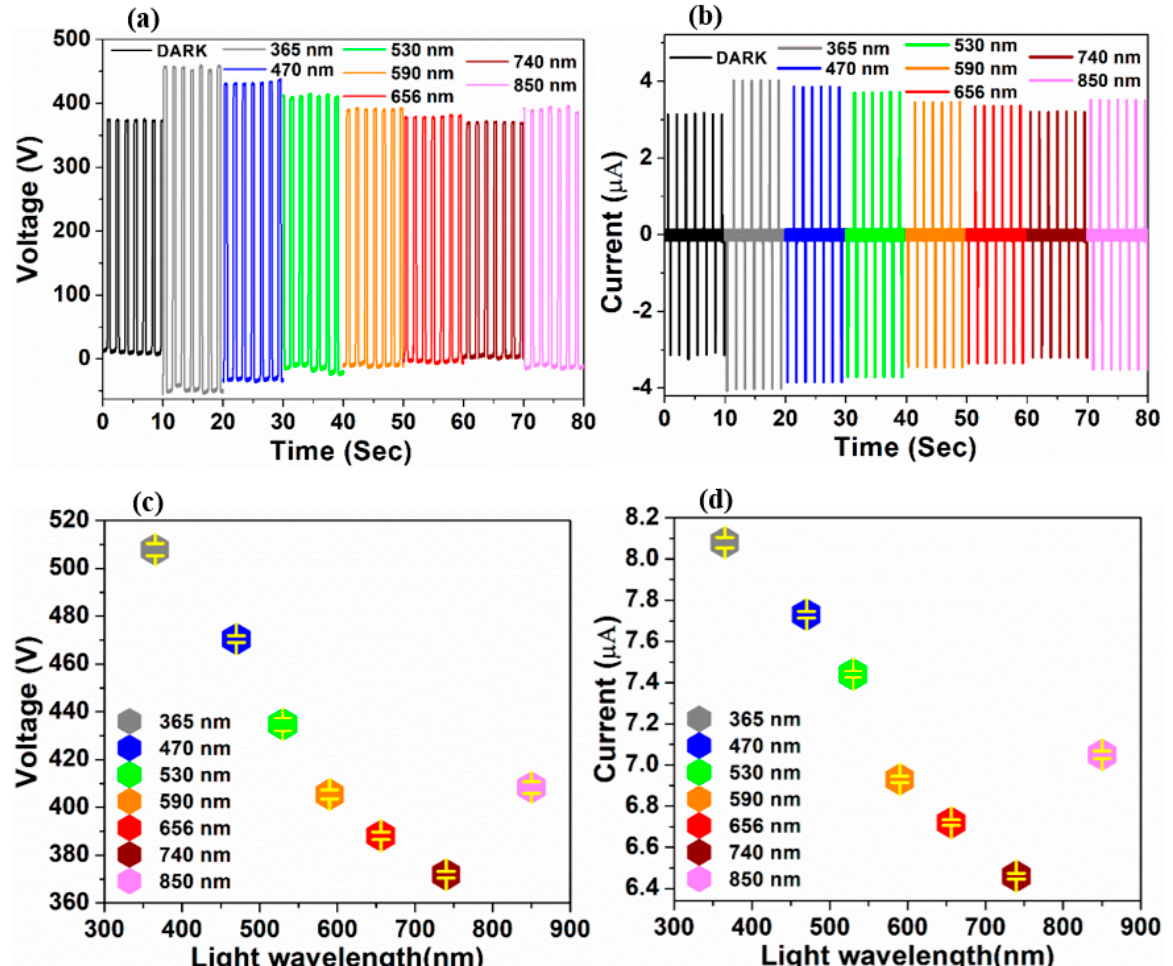
Figure 6. Variation in ( a ) voltage and ( b ) current signal of PDMS/ α− Fe 2 O 3 nanocomposite − based TENG upon illumination with several different wavelengths. The variation of the mean magnitudes of peak − to − peak ( c ) voltage and ( d ) current outputs (with standard deviations) of the TENG under illumination with different wavelengths.